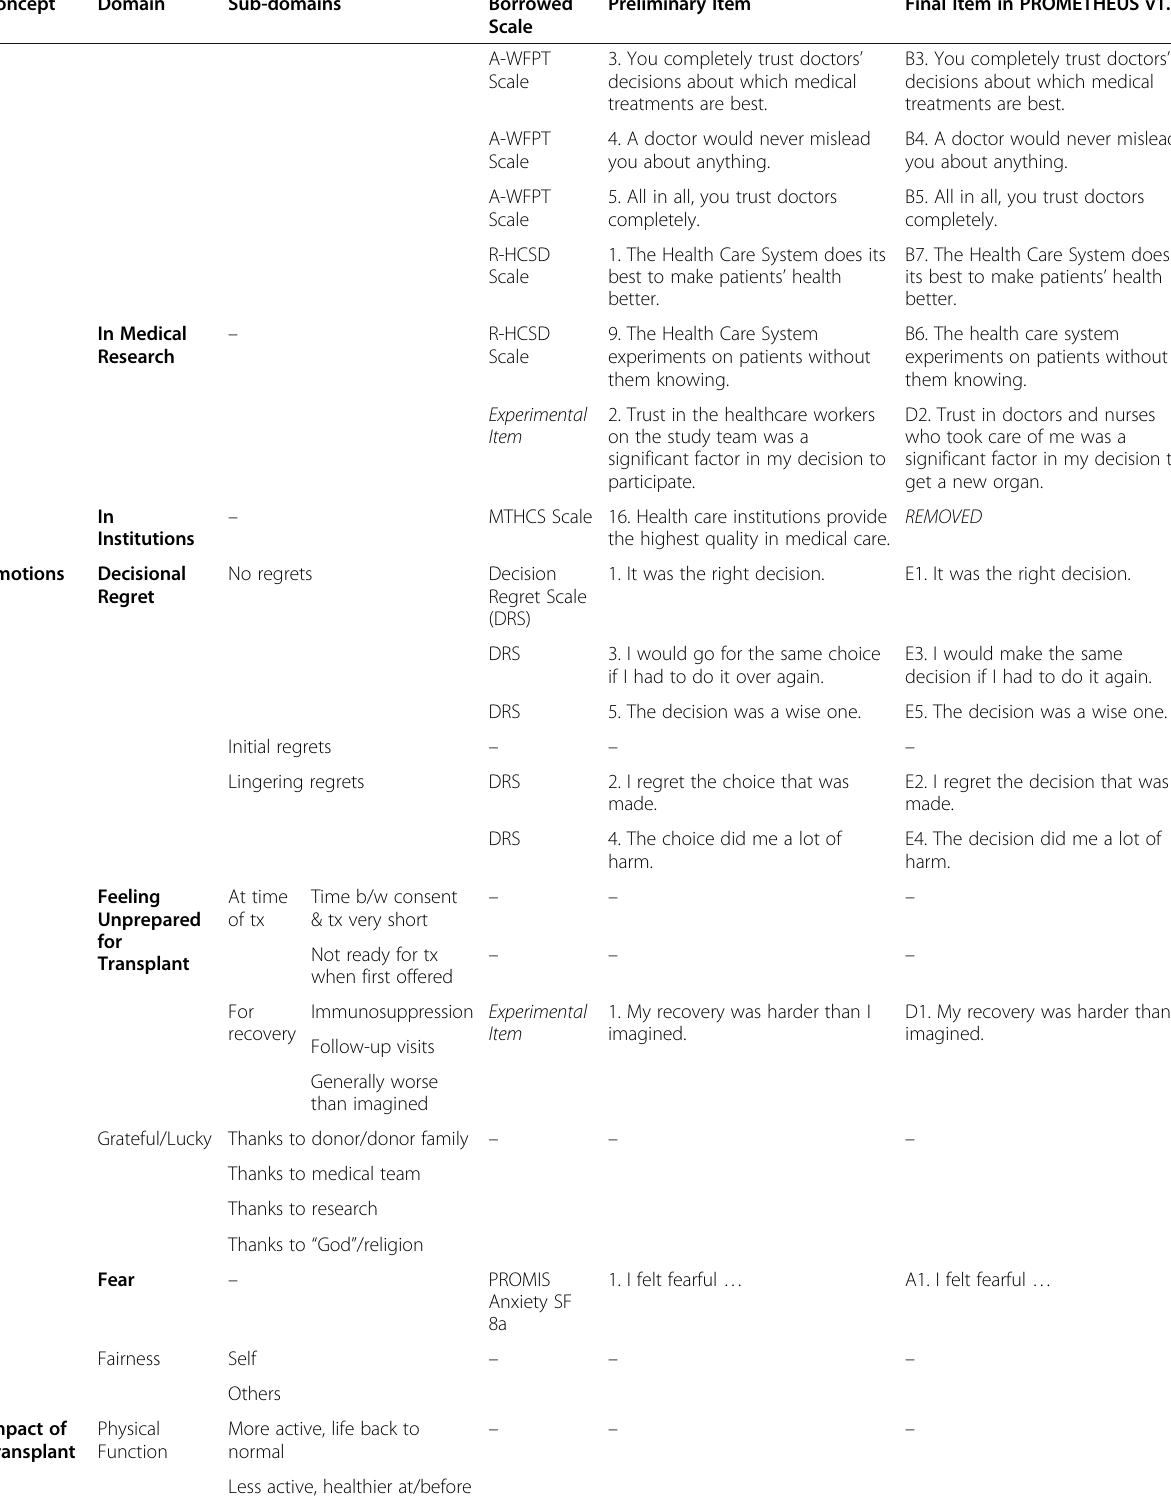
Table 2 PROMETHEUS concepts and domains with items (Continued)